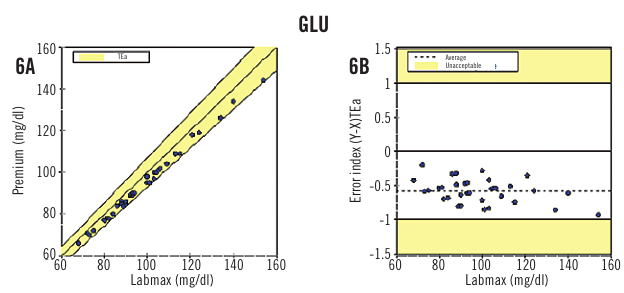
figurE 6 − Comparisons between GLU measurement for 2 automated chemistry platforms A) linear regression for GLU measurements between instruments Labmax 240 ® (E1) and Labmax 240 Premium ® (E2): n = 40, r = 0.998, p < 0.05; equation for the correlation: E2 = 0.933*E1 + 2.5; TEa = 7%; B) graph comparing the systems Labmax 240 ® (E1) and Labmax 240 Premium ® (E2) for GLU measurement: error index = [(result - mean)/TEa] (table of biological variation); results > +1 and < -1 are considered inadequate ( n = 40). GLU: glucose; TEa: allowable total error.